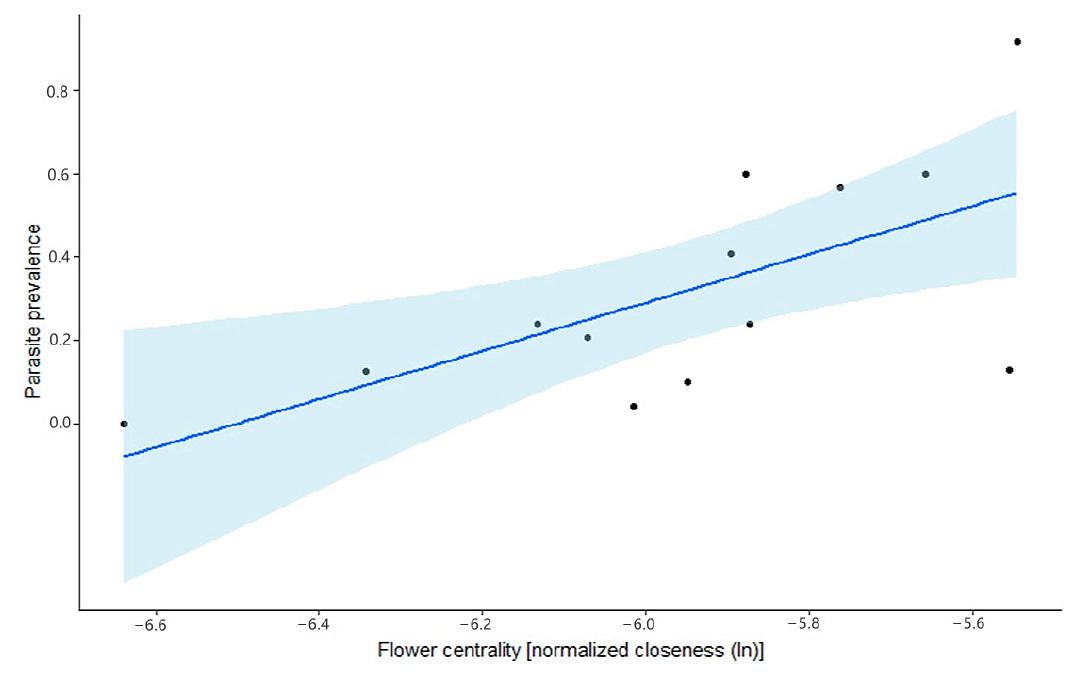
Figure 3. ResultsofthegeneralizedlinearmixedModel3(GLMM3): interactioneffectofflowercentrality (ln-transformed normalized closeness; x -axis) and parasite prevalence ( y -axis), i.e., Neogregarinorida and Trypanosomatidae taken together (presence / absence data). Parasite prevalence and centrality are plotted (black dots) for each analyzed plant species in each study site. Shaded blue shows the 95% confidence